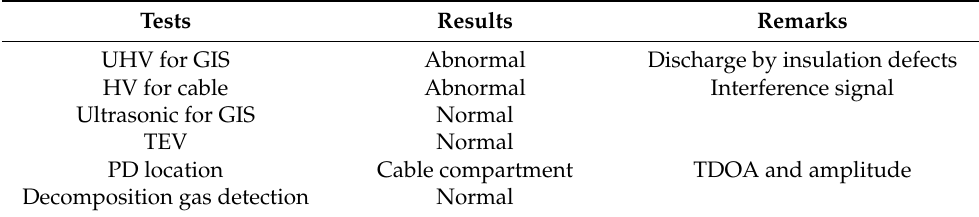
Table 3. Test items and related results of 2202 bay of 220 kV Chuanye Station.